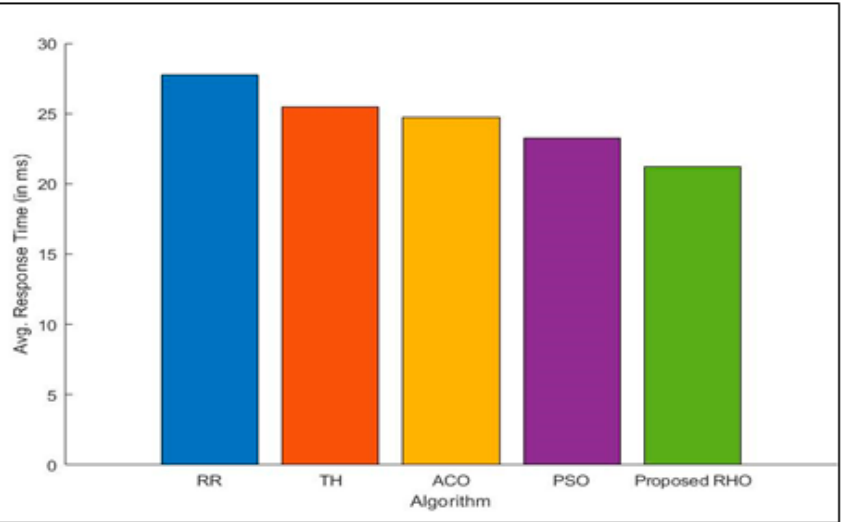
Figure 4. Average Response Time for different algorithms.